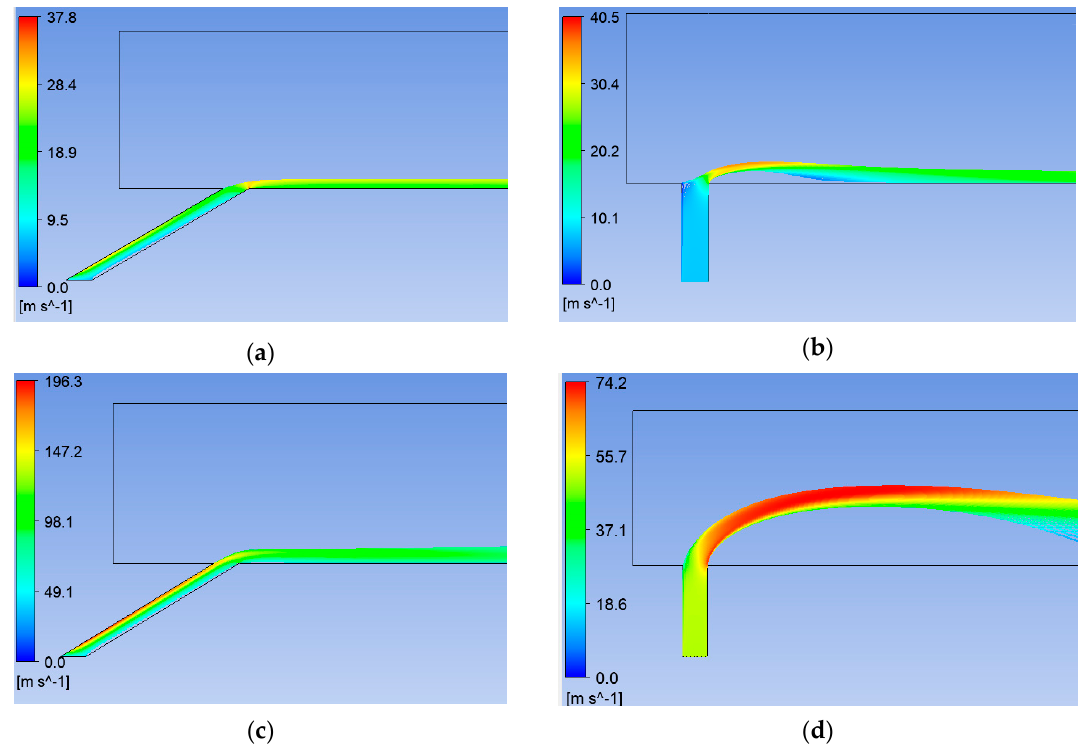
Figure 10. Velocity streamlines from the coolant jet for (a) 𝑀 = 0.1 and 𝛼 = 30 , (b) 𝑀 = 0.3 and 𝛼 = 90 , (c) 𝑀 = 2.0 and 𝛼 = 30 , and (d) 𝑀 = 2.0 and 𝛼 = 90 .